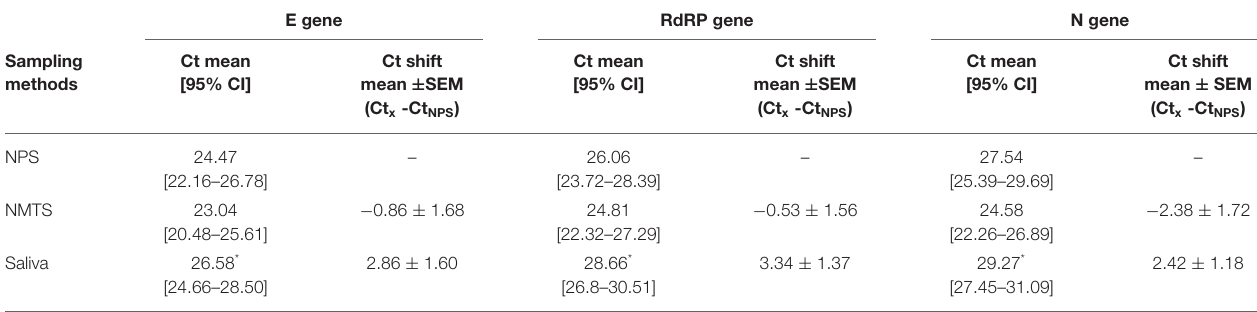
TABLE 2 | Impact of sampling method on the RT-qPCR Ct values according to the target gene. E